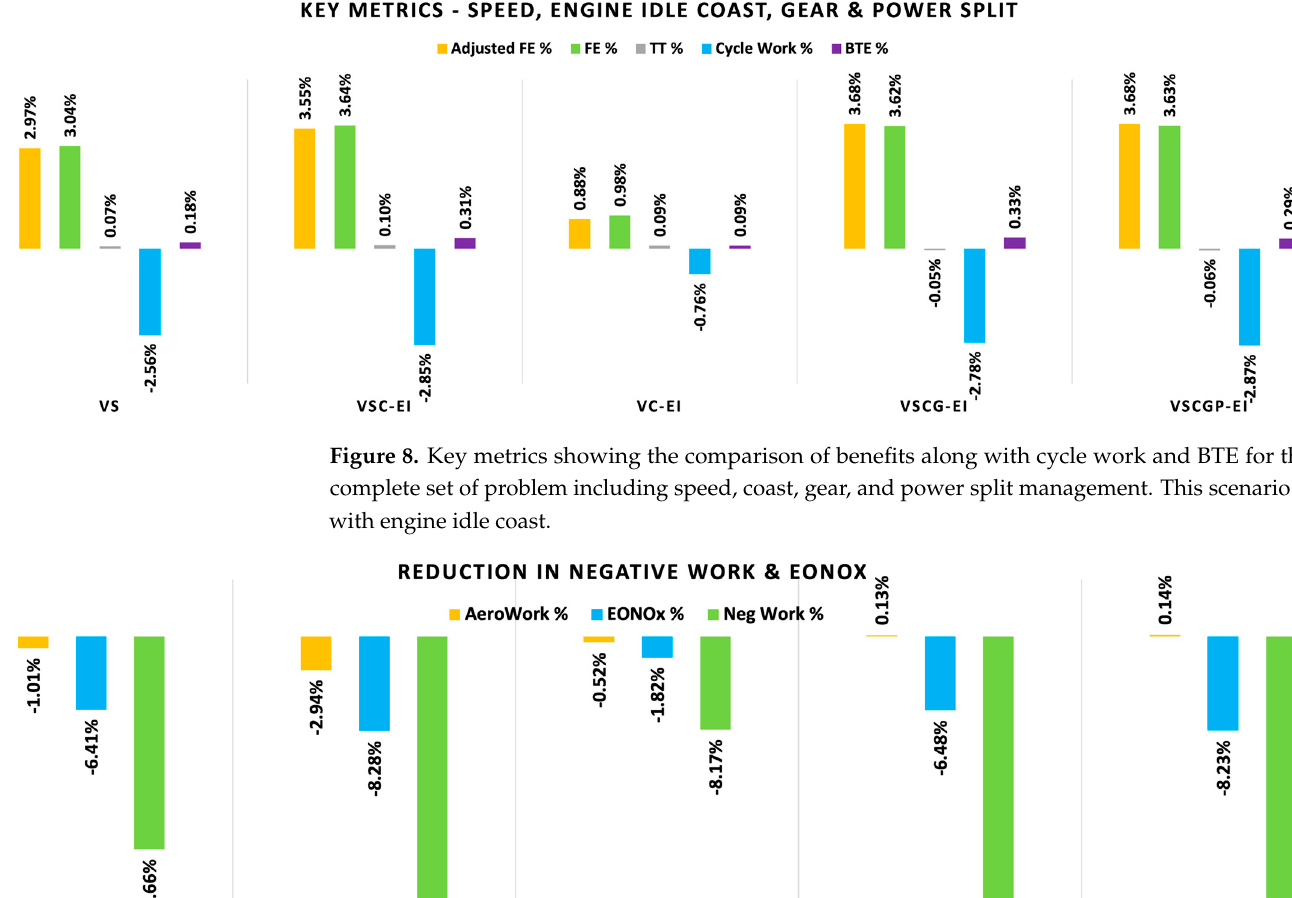
15 Figure 7. % Time in top 4 gears for each DOE. The comparison must be between the top 2 gears. Predictive gear tries to operate more at a lower gear while fuel economy tends to operate at a higher gear.